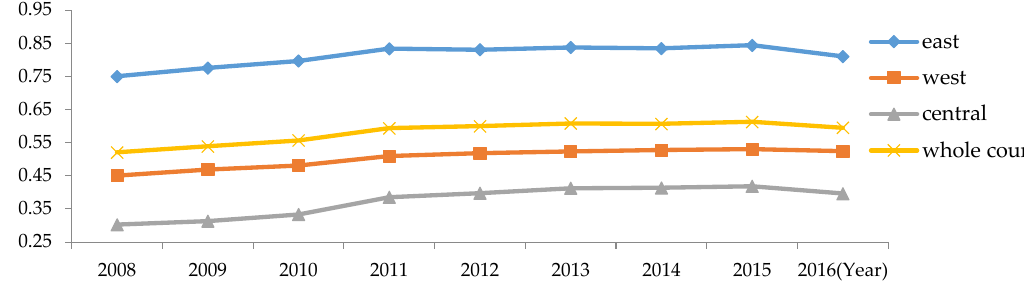
Figure 2. China’s average water use efficiencies.